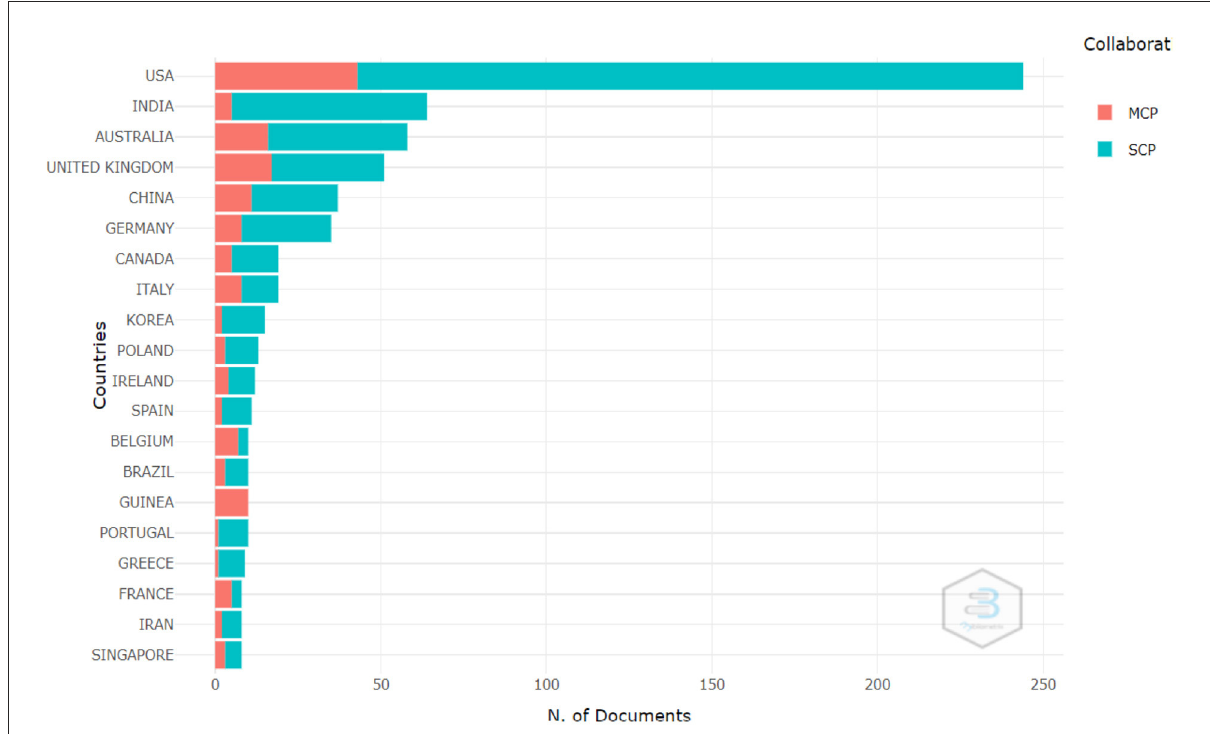
FIGURE9 Correspondence between author and country. Source: Own elaboration using Bibliometrix.